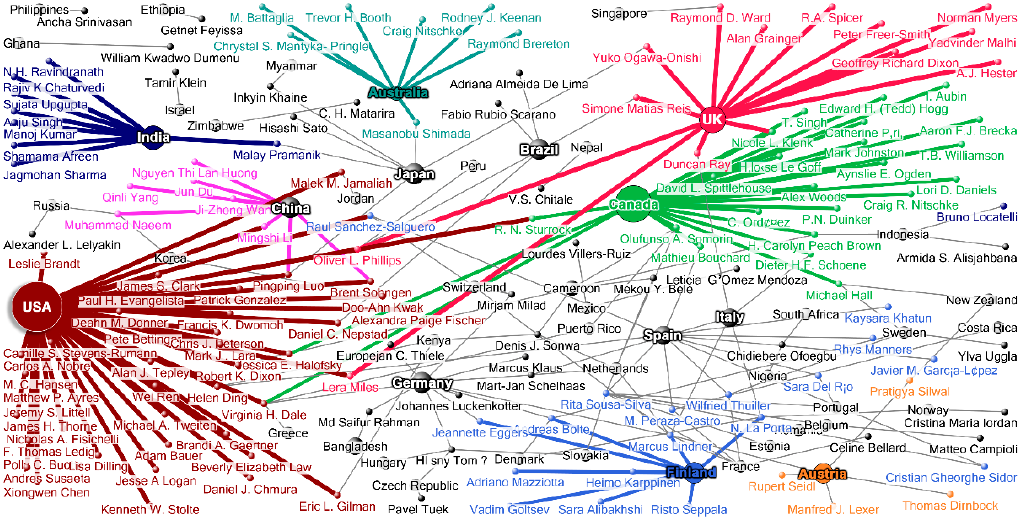
Figure 4. Global distributions of author collaboration.